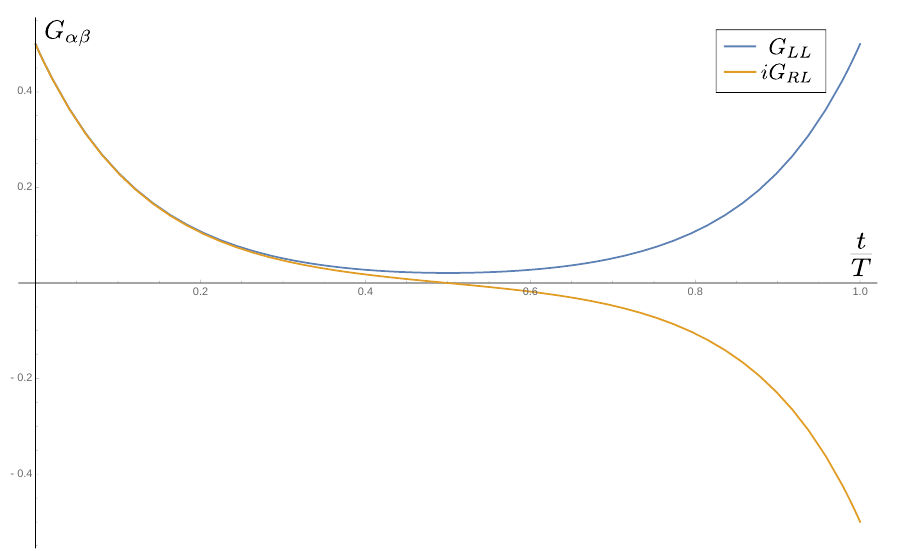
Figure 6 . Solution for the ramp saddle point glued together from the early-time part (4.29)–(4.30) and the late-time part